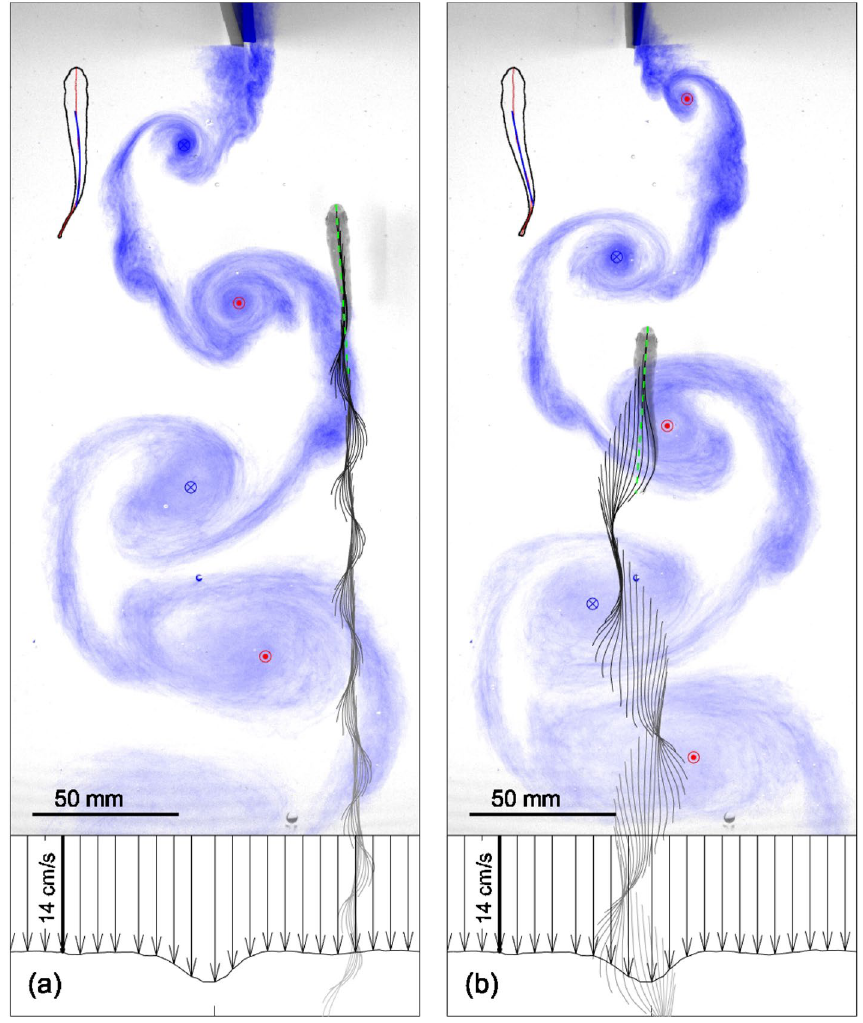
Figure 1. Fish exhibit two distinct swimming gaits: ( a ) regular swimming outside the wake in the uniform flow field and ( b ) swinging between vortices. Sequential positions of the fish centreline advected downstream with the mean flow velocity are imposed on the ink visualisation of the reverse Kármán street, obtained in separate experimental series. Profiles of the mean streamwise flow velocity are shown below the images. In the top left corner, the contour of the fish body is shown with the part of the centreline associated with muscle marked blue.